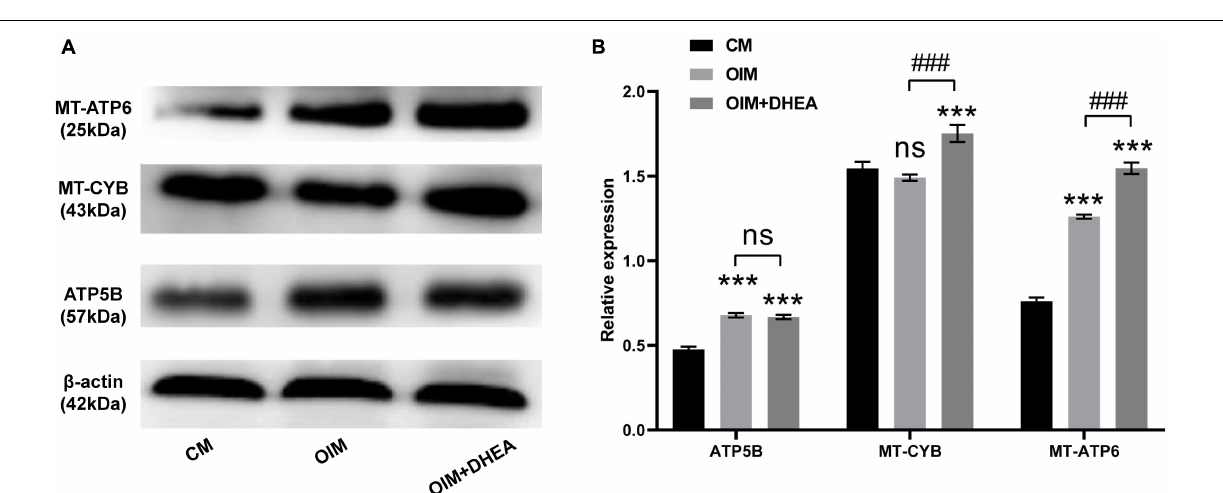
FIGURE 7 | Protein expressions of ATP5B, MT-CYB, and MT-ATP6 were increased in the OIM group and OIM+DHEA group. (A) The expression of ATP5B, MT-CYB, and MT-ATP6 protein were assessed by western blot analysis, β -actin as a loading control. (B) The quantification of expression levels of ATP5B, MT-CYB, and MT-ATP6 proteins, the data were presented as the mean ± SD for each group (*** p < 0.001; ### p <